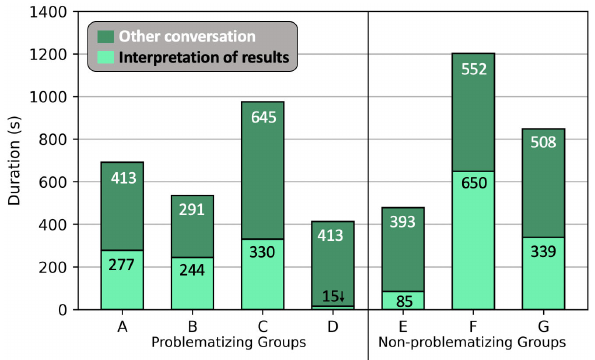
FIG. 8. The time spent in other conversation is similar across all groups, with the time spent discussing interpretation of results varying from a low of 15 sec (group D) to a high of 650 sec (group F).